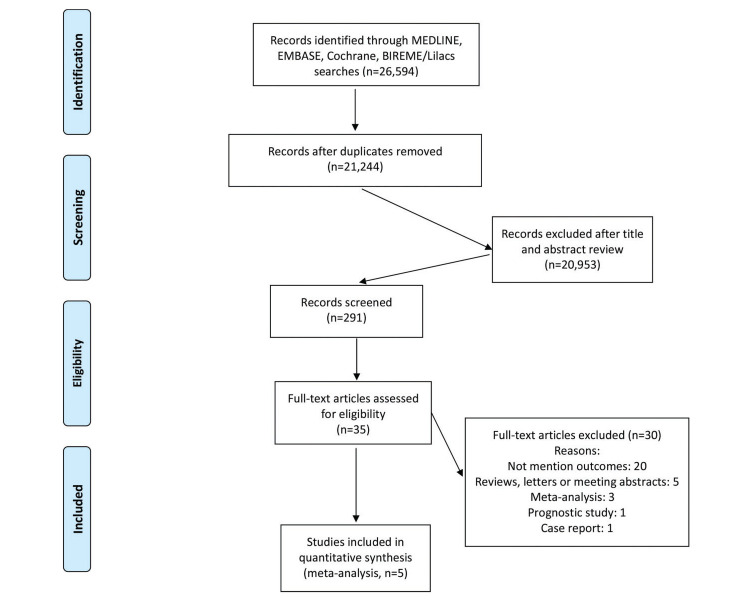
Prisma Flow Chart.